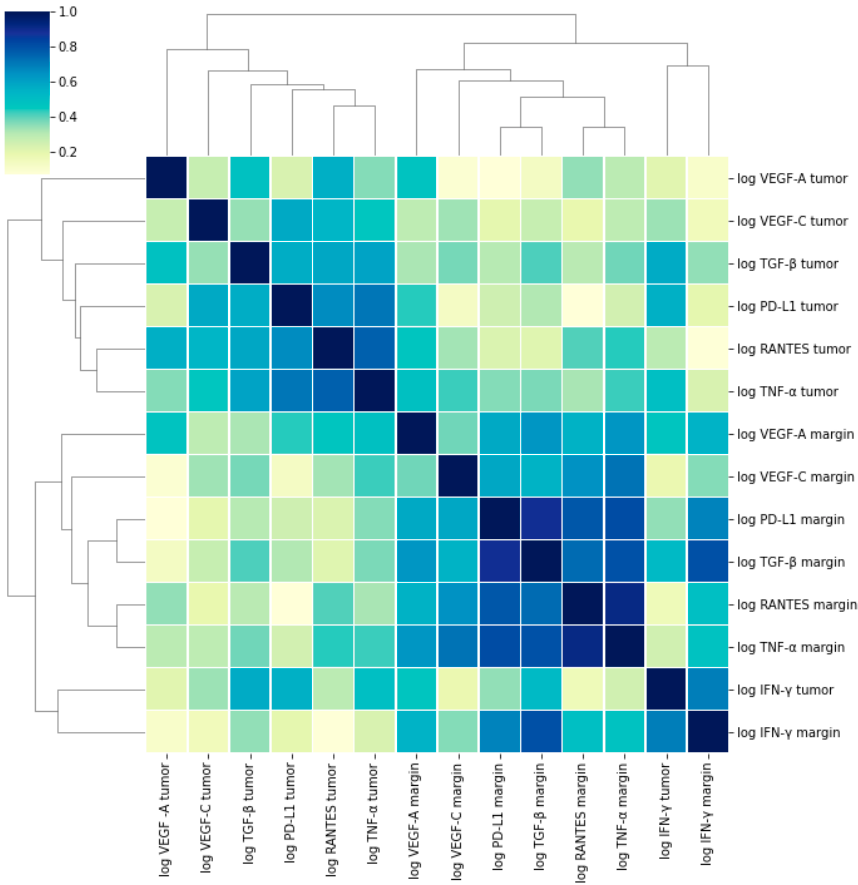
Figure 2. Graphical representation of linear regression results assessing correlations between log RANTES and log PD ‐ L1, respectively, in tumor and margin tissue.